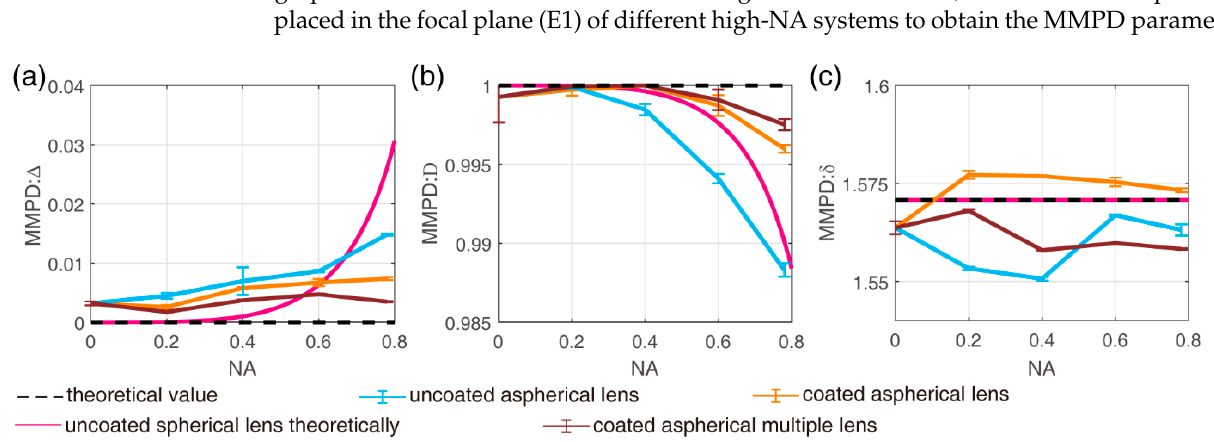
Figure 7. Experimental results of MMPD parameters ( a ) Δ of air, ( b ) D of a linear polarizer, and ( c ) δ of a quarter-wave retarder, for four high-NA lens systems: uncoated spherical lens (pink lines), uncoated aspherical lens (blue lines), coated aspherical lens (orange lines), and coated aspherical multiple lenses (purple lines), with NA increases from 0 to 0.2, 0.4, 0.6, and 0.78. The black dotted lines show the theoretical values.